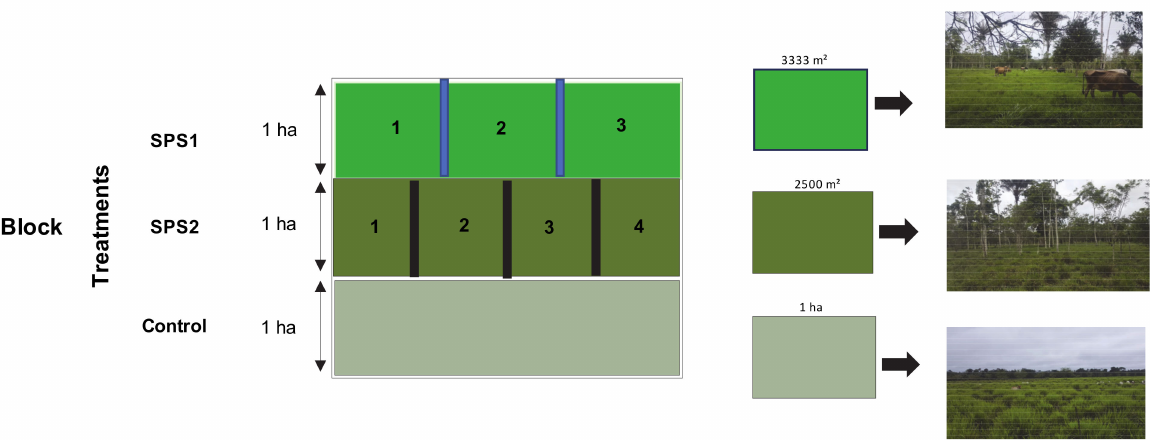
Figure 2. Scheme of experimental design of guinea grass Panicum maximum under silvopastoral systems in combination with different management